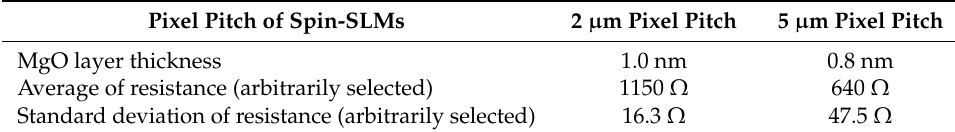
Figure 7. The transistor characteristics (red) and load line (black) of the 2 µm spin-SLM.